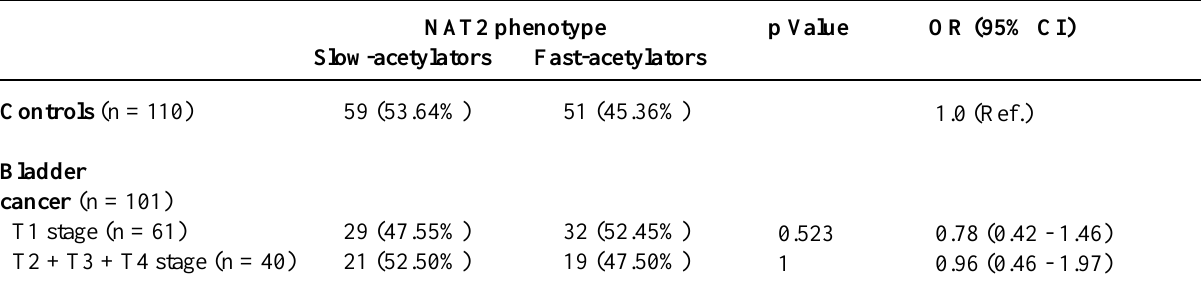
Table 3 – Frequency of N-acetyltransferase-2 genotypes of bladder cancer patients categorized by stage of the disease.